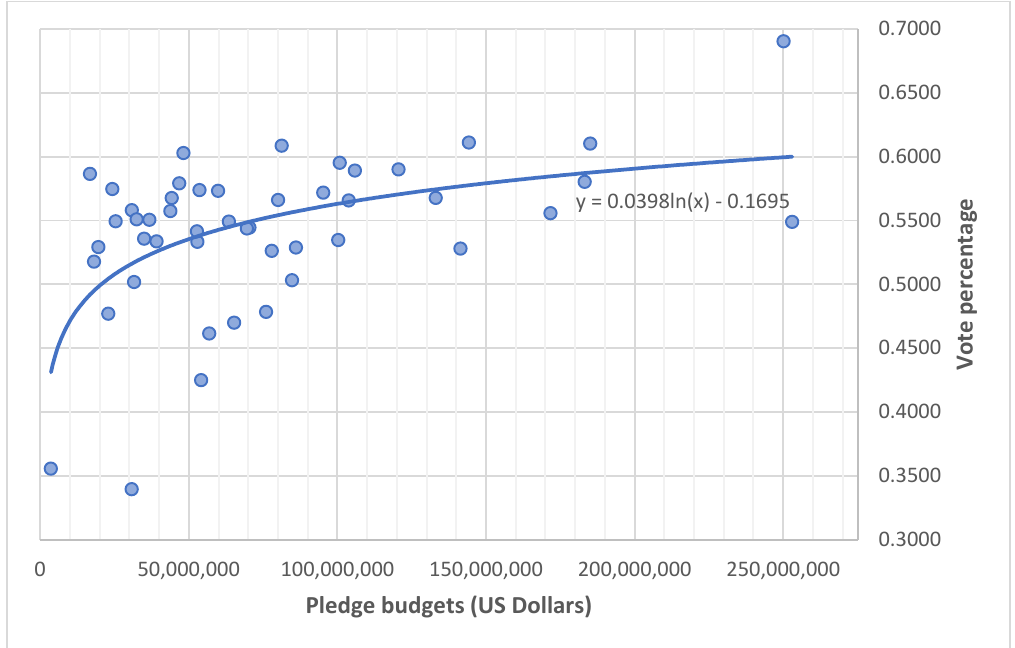
Figure 3. The slope of the vote percentage according to pledge budgets.